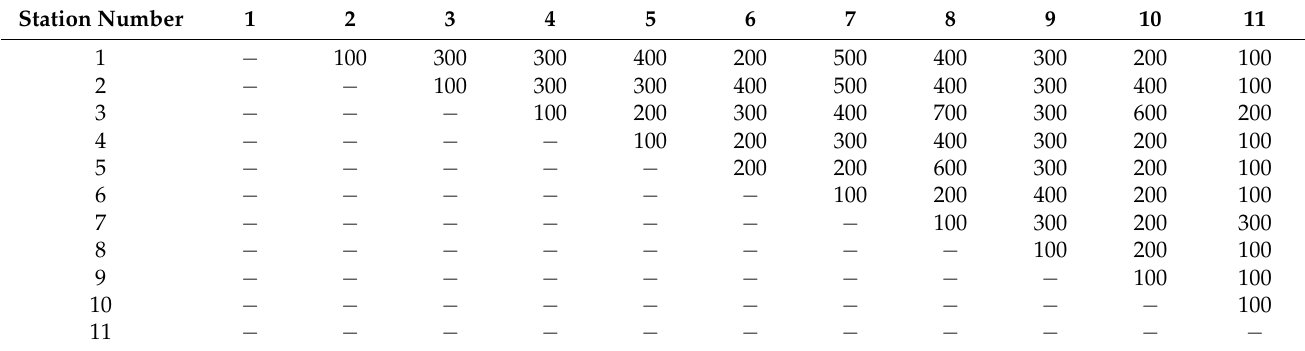
Table 3. Suburban railway passenger demand in one operation cycle.